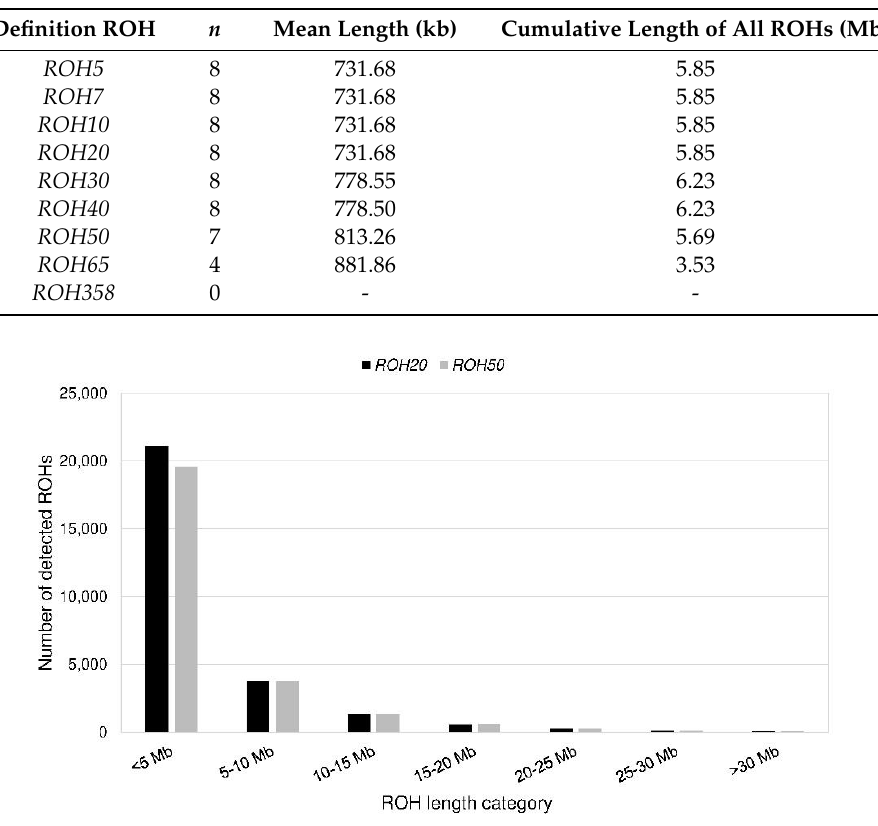
Table 4. Overview of the amount and length of runs of homozygosity (ROHs) shared by at least 75% of the genotyped dogs. A ROH was defined in nine different ways. For all definitions the number ( n ) of ROHs, the mean length of detected ROHs and the cumulative length of all ROHs are given.